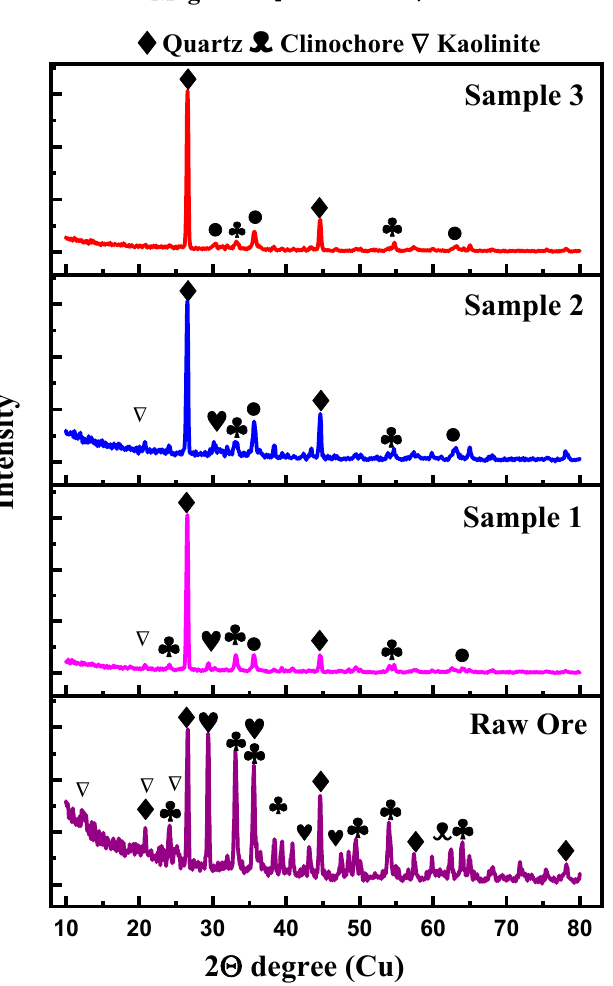
Figure 7. XRD results of raw and roasted ore at different temperatures.